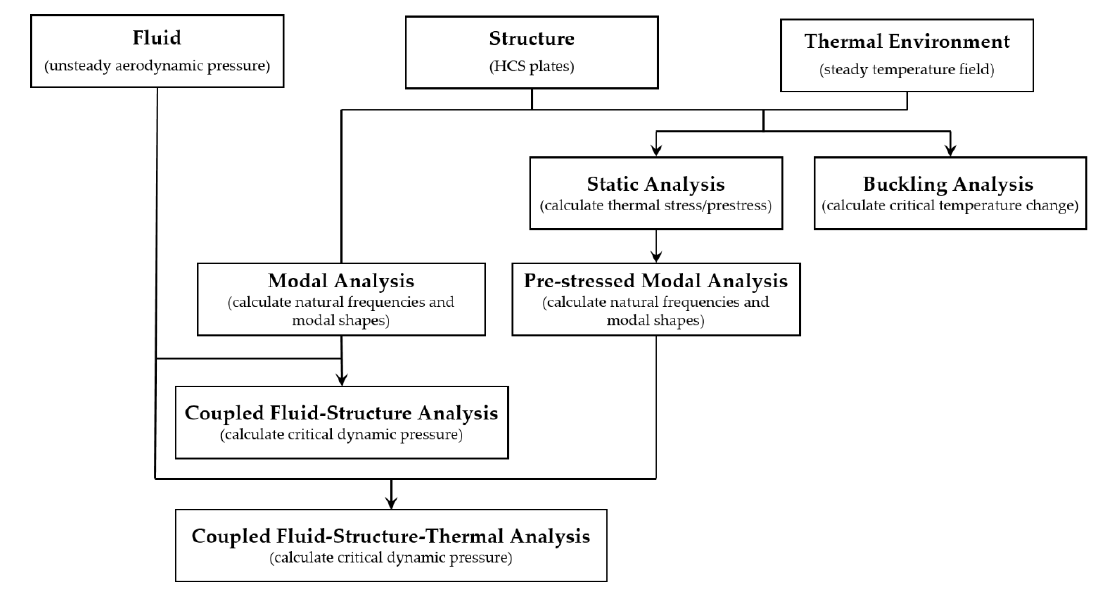
Figure 2. A flowchart of the solution procedure.